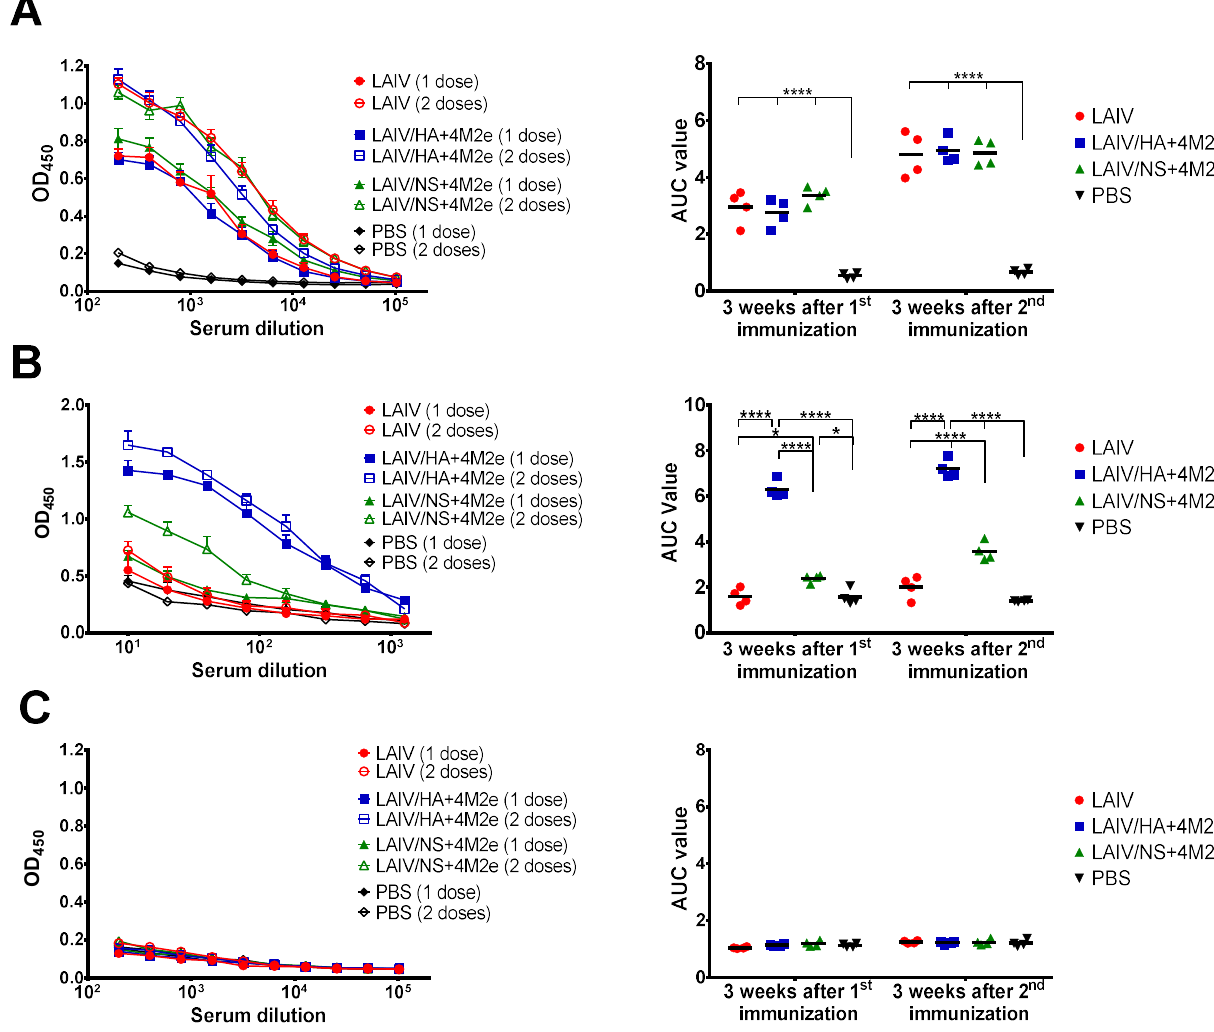
Figure 7. Serum IgG antibody immune responses after vaccination. Ferret sera were collected three weeks after the first and the second intranasal immunization. IgG antibody levels were assessed in ELISA with different antigens. ( A ) H3N2 LAIV whole virus. ( B ) 3M2e recombinant protein. ( C ) S.A. H1N1 whole virus. Left panel shows mean OD 450 values for each serum dilution. Right panel shows the area under the OD 450 curve values for each individual animal. Data were analyzed by two-way ANOVA with Tukey’s post-hoc multiple analyses test. * p < 0.05; **** p < 0.0001.